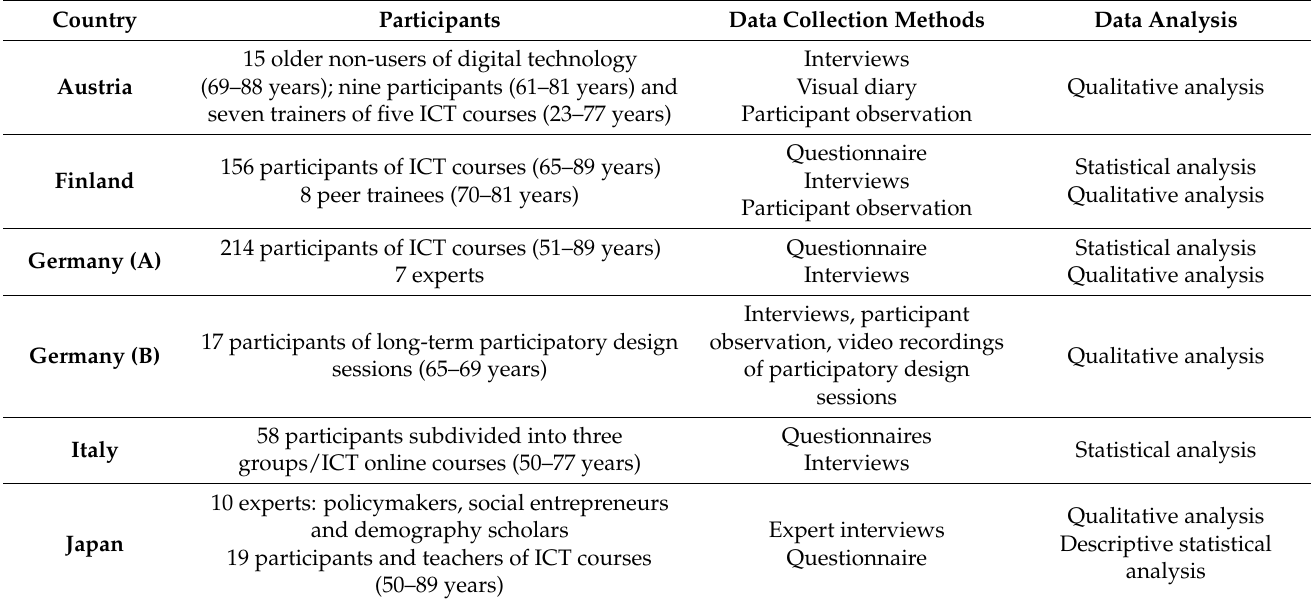
Table 1. Participants, data collection and analysis